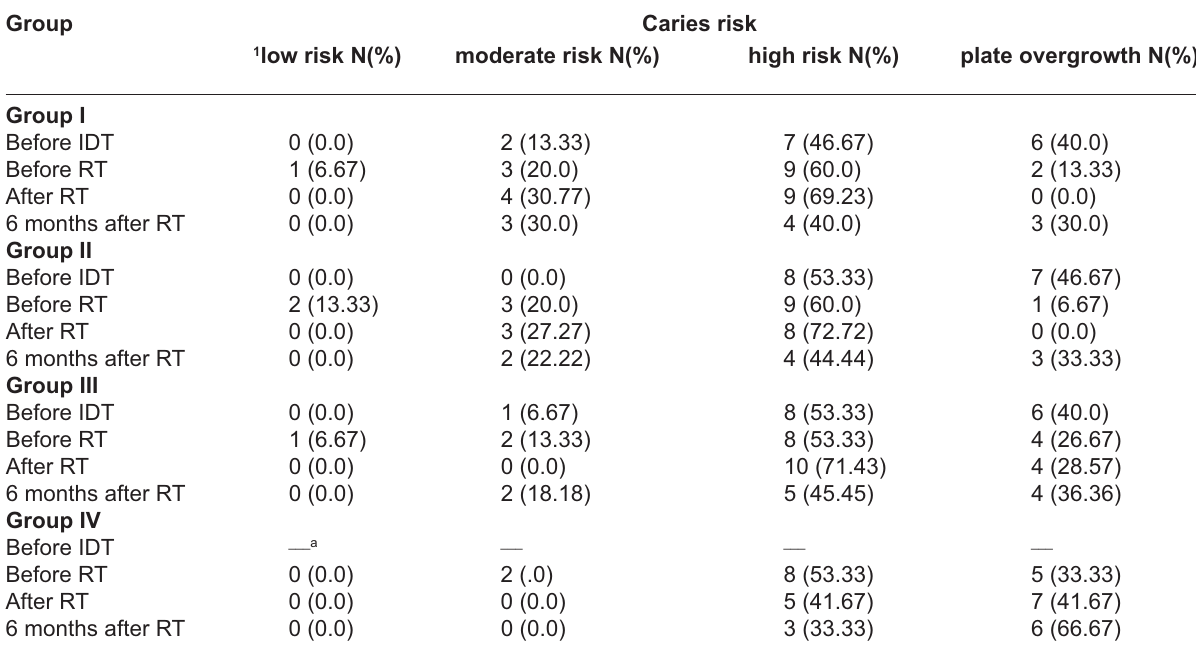
Table 3- Effects of preventive protocols on dental caries risk in irradiated patients. Results of mutans streptococci counts were obtained by